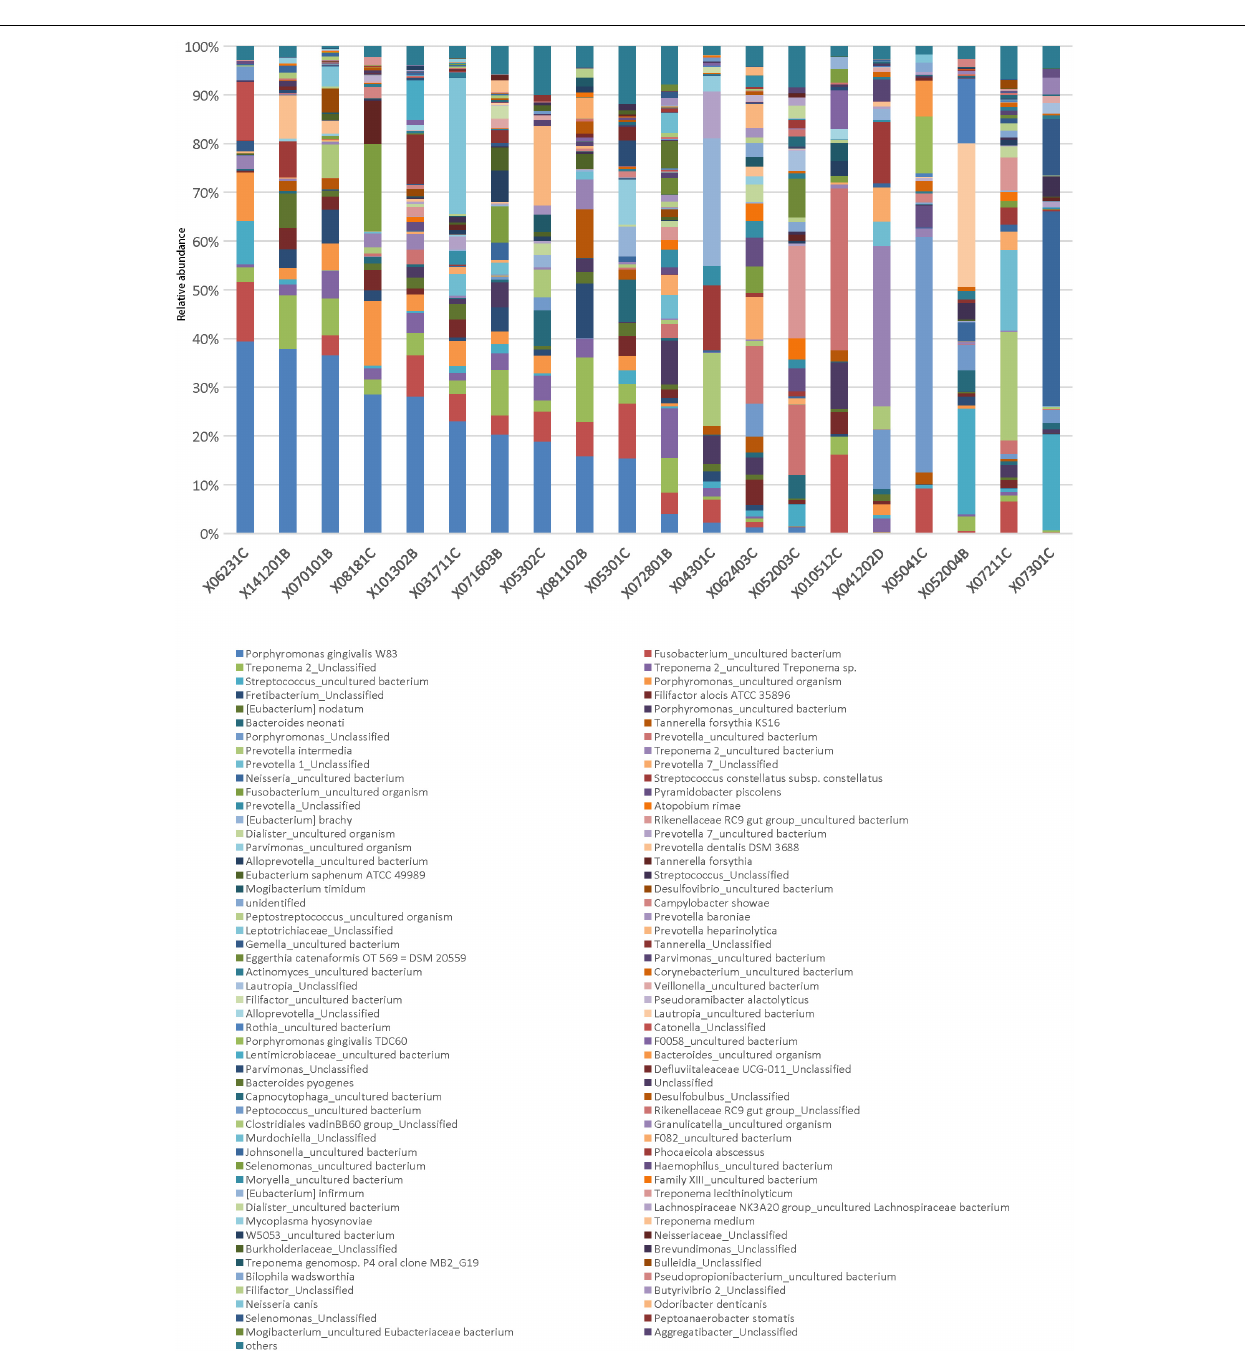
FIGURE 3 | Relative abundance of genera in the AB group. Each column represents a sample in the AB group. The genera were sorted in descending order of average abundance in abscess samples. Different bacterial taxonomies at the genus level are shown in different colors on the bottom. Abundance cutoff in this bar graph was set at 1%; some below 1% were shown as